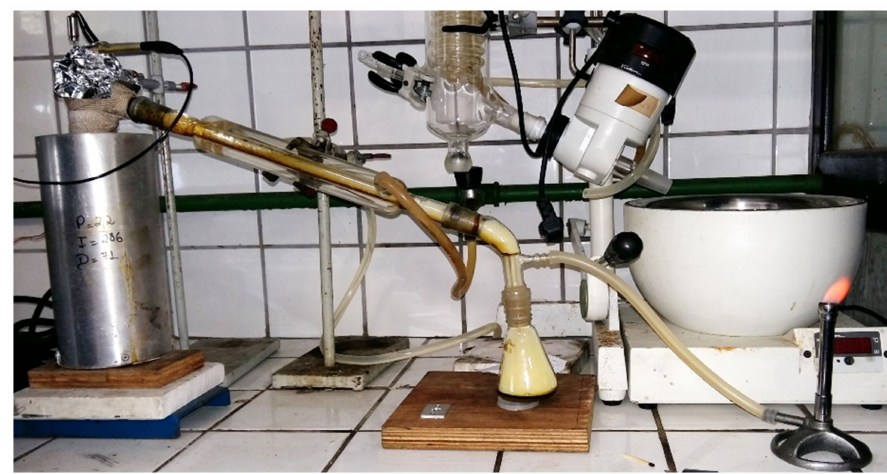
Figure 3. View of the pyrolysis unit in laboratory scale.